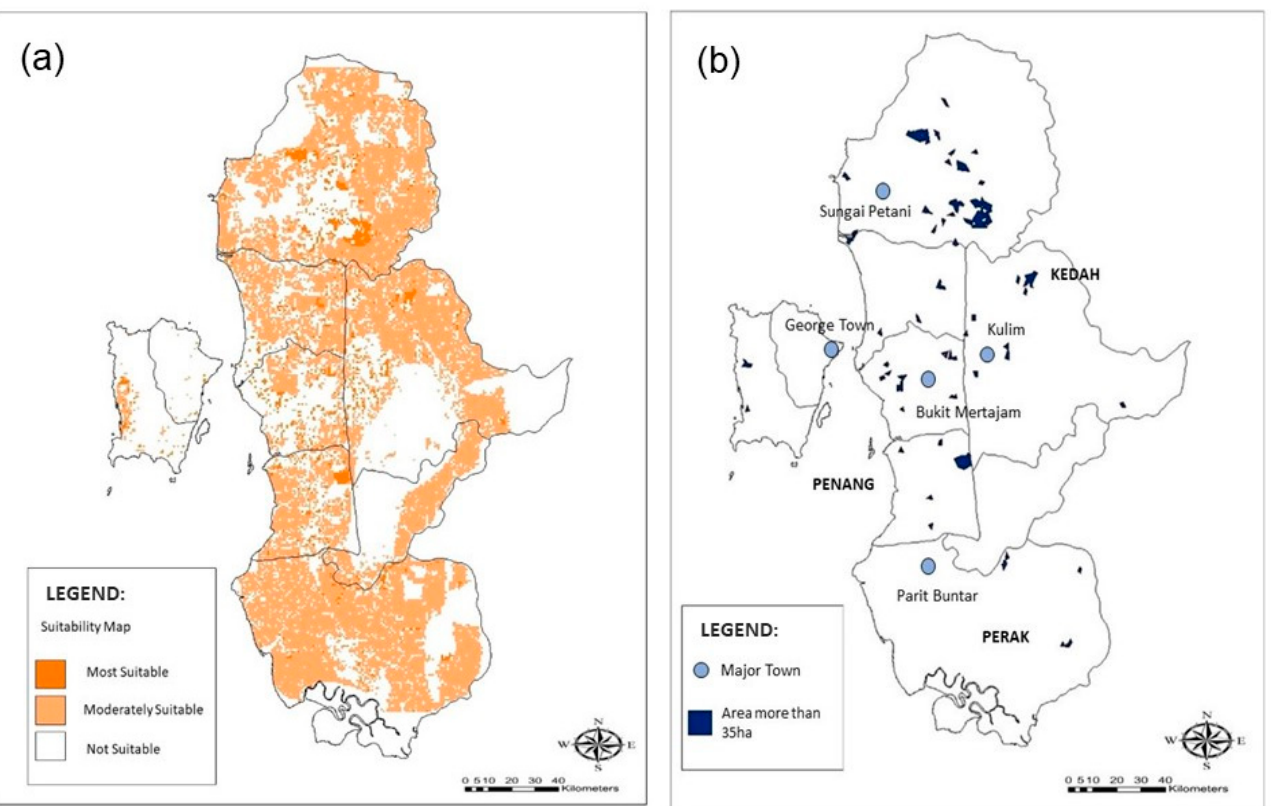
Figure 8. ( a ) Final suitability map for aquaculture development in George Town Conurbation and ( b ) most suitable sites with a size of more than 35 ha.